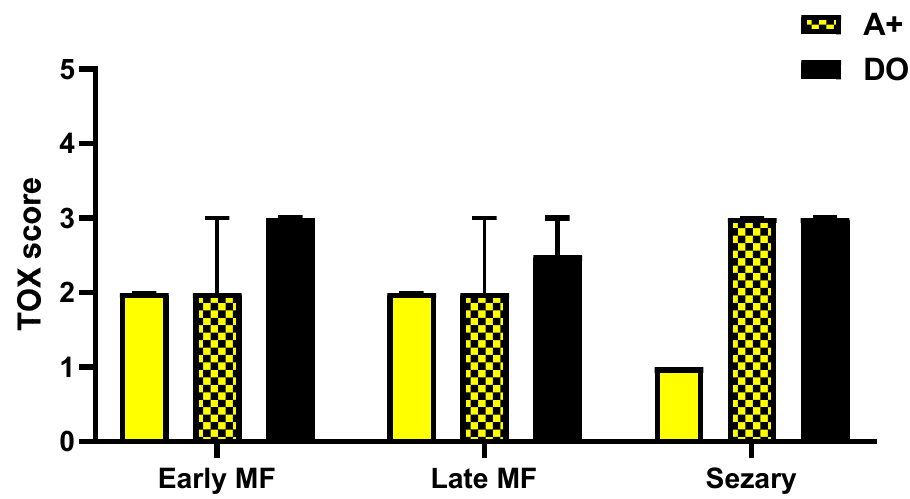
Figure 6. TOX expression in biopsies of A − , A+ and DOD patients considering separately the three groups of early MF, late stage MF and Sézary Syndrome.